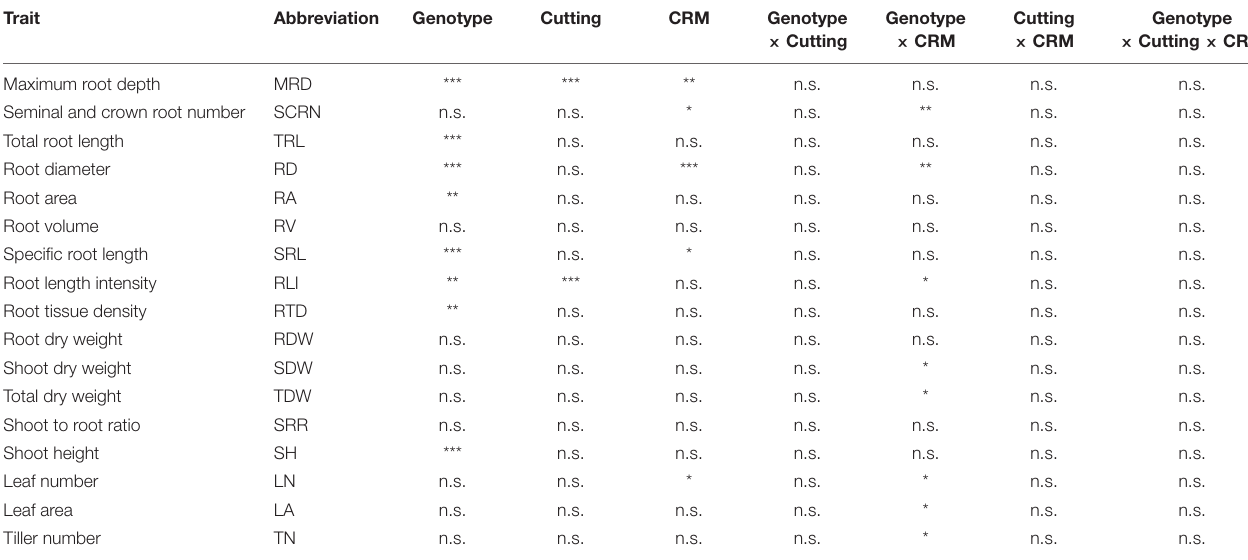
TABLE 6 | Effect of crown root number manipulation (CRM) and root cutting on 17 major traits in Taichung 65 and YRL38 grown in a semihydroponic phenotyping platform for 41 days after transplanting. Trait Abbreviation